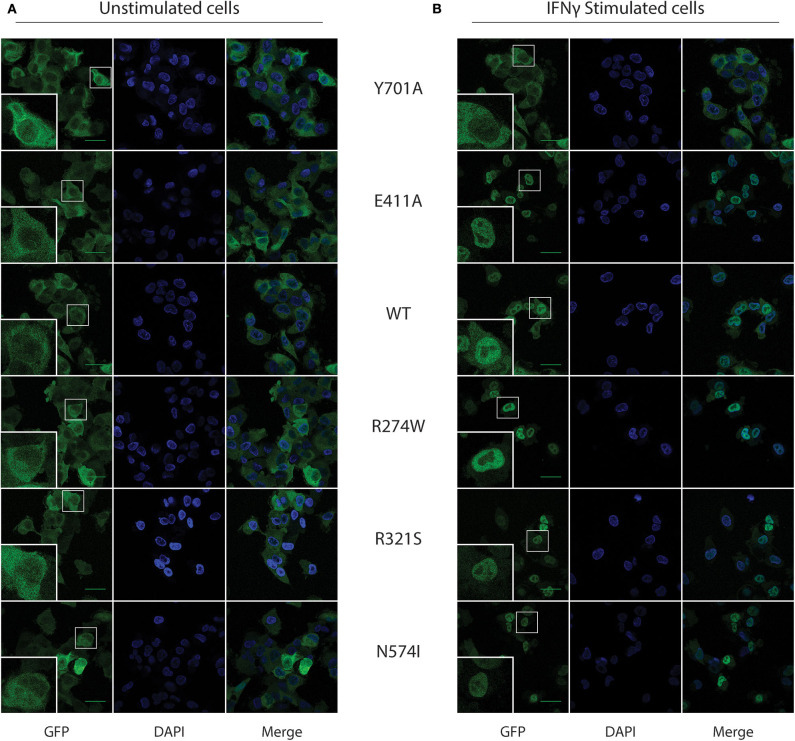
STAT1-GFP subcellular localization in U3A cells before and after IFNγ stimulus. (A) Confocal images for the respective STAT1 GFP expressing, unstimulated, U3A cells. (B) U3A cells after 1 h of IFNγ (1 U/μl) stimulation. Green scale bar is 40 μm. Bottom left inset in each image shows a zoom-in of the cell in the smaller white box.